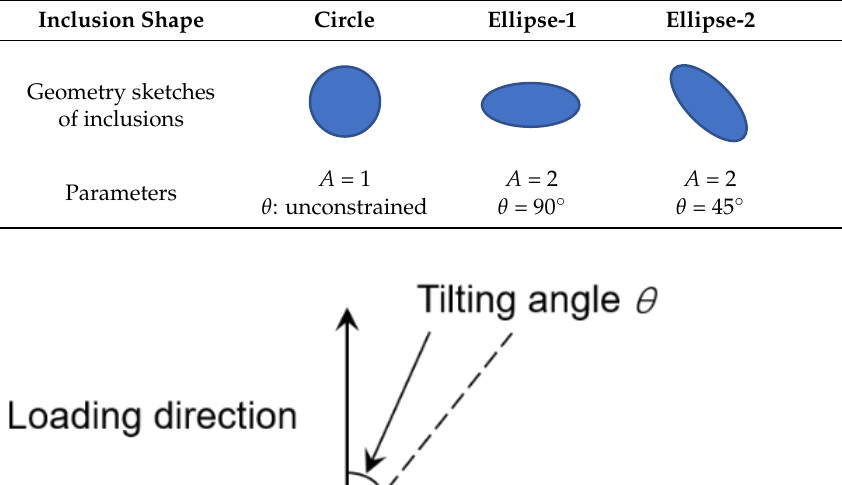
Table 1. Geometry sketches of inclusions with different shapes in this study and the corresponding values of aspect ratio A and the rotation angle θ .